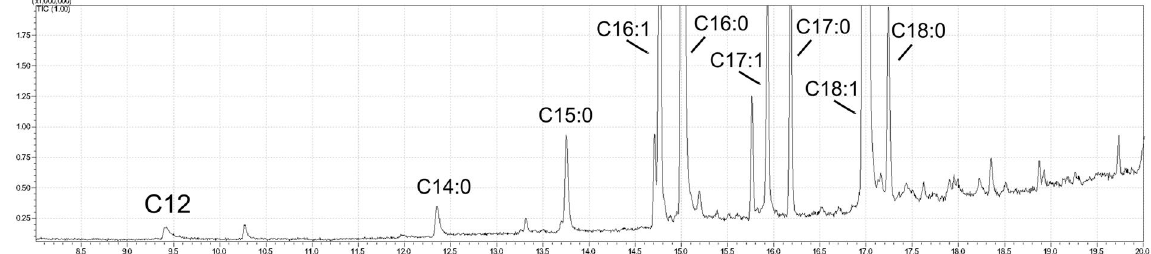
Figure 2. GC-MS analyses of FAMEs released by acid methanolysis from the total lipid extract. Carbon atoms and unsaturations of various fatty acid chains are